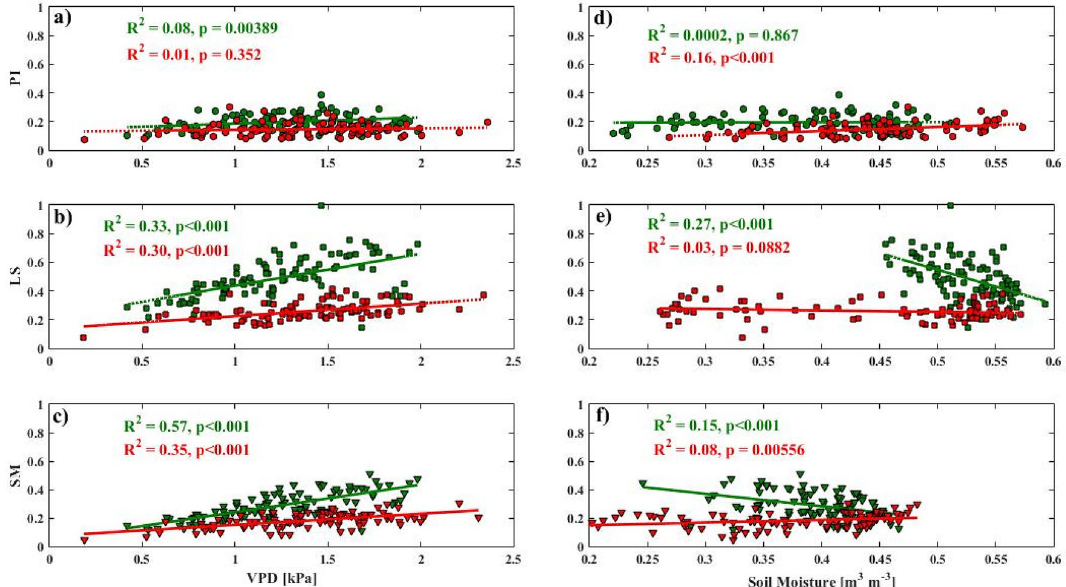
Figure 5. Daily averages of transpiration ( E L ) plotted against VPD ( a – c ) and soil moisture ( d – f ) with the rows corresponding to the three species: P. indicus (PI), L. speciosa (LS), and S. macrophylla (SM), and seasons plotted in green (wet) and red (dry) symbols. This figure was generated using MATLAB version 7.12.0 R2017a (https :// www.mathw orks.com/produ cts/new_produ cts/relea se201